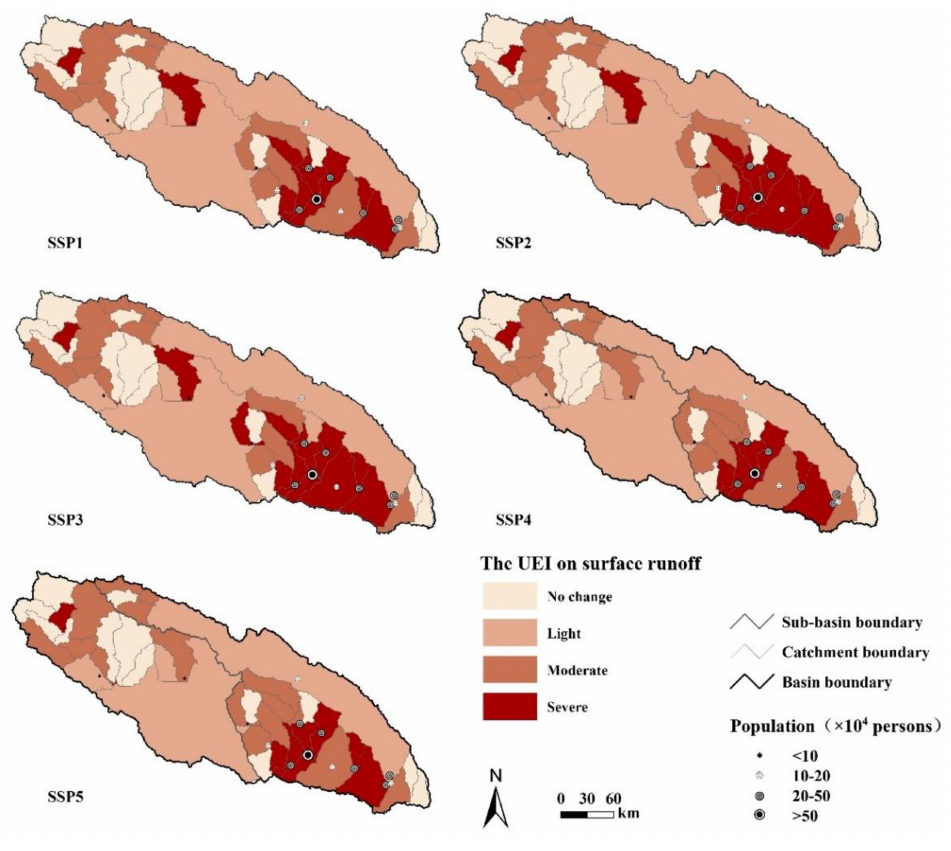
Figure 8. The UEI on surface runo ff from 2018 to 2050. Table 7. The UEI on surface runo ff from 2018 to